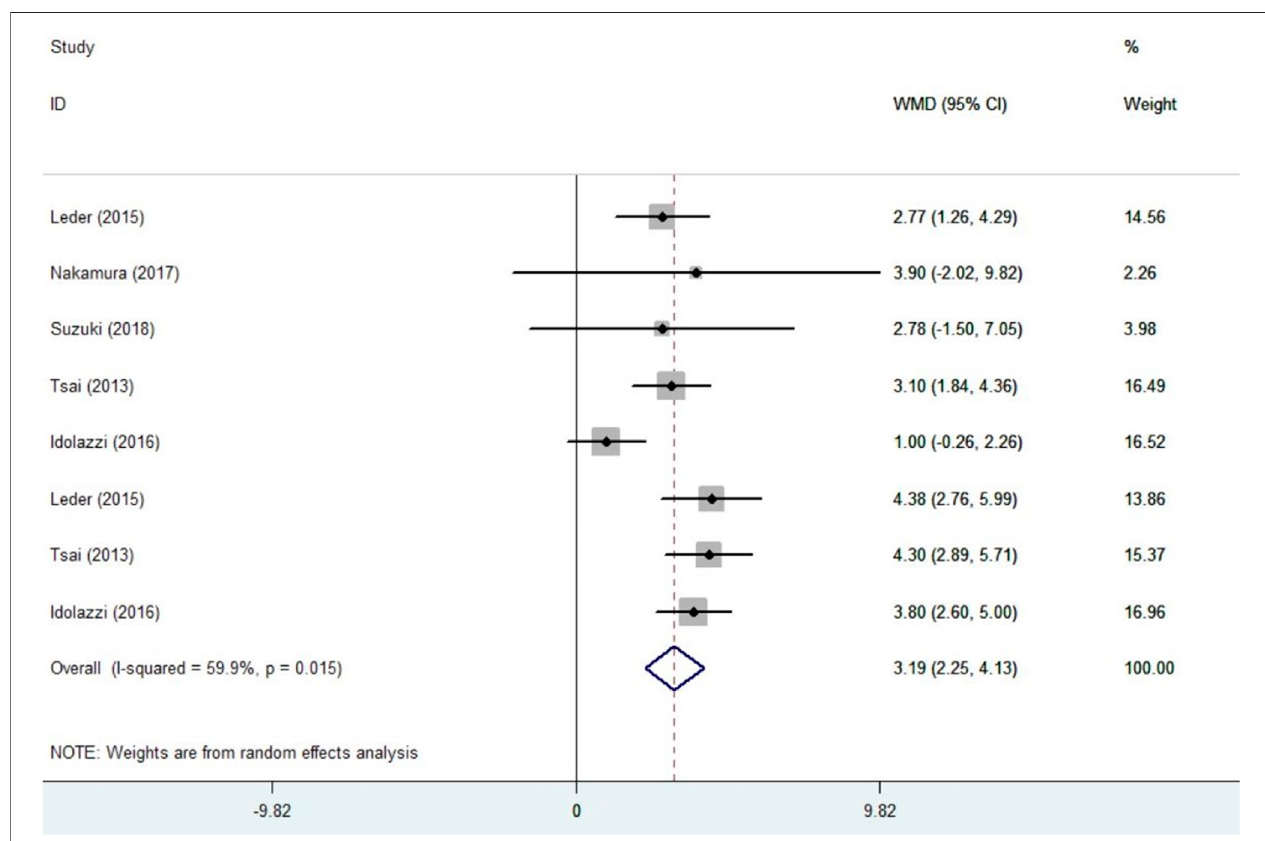
FIGURE 3 | Forest plot for the total hip BMD